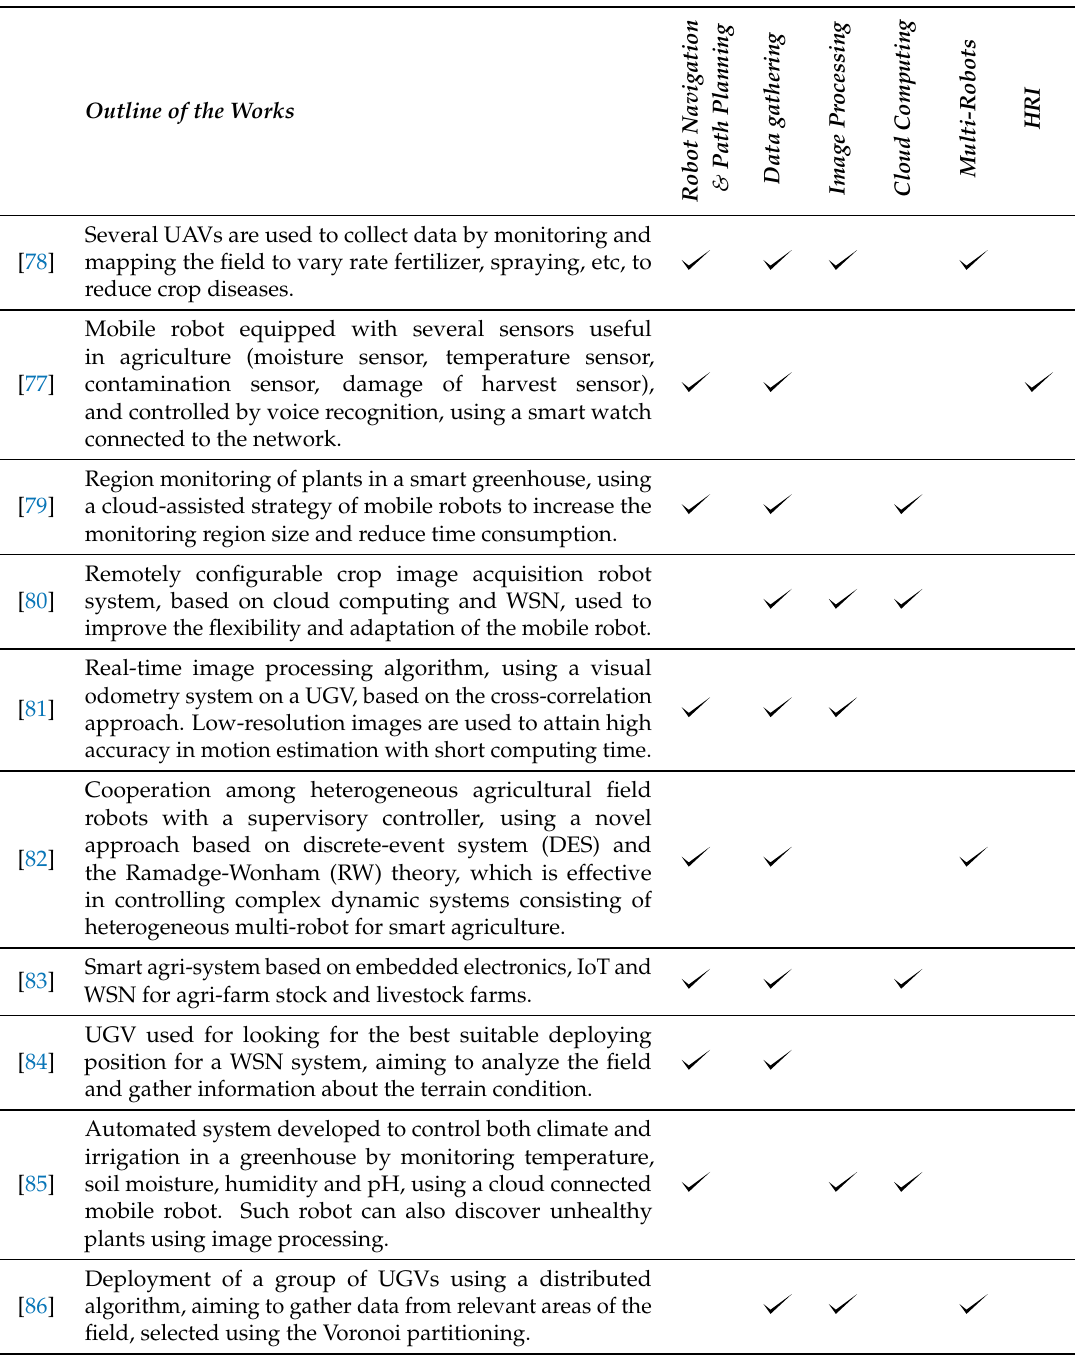
Table 2. Overview of the literature considered for the Agriculture domain, from 2018 onwards.